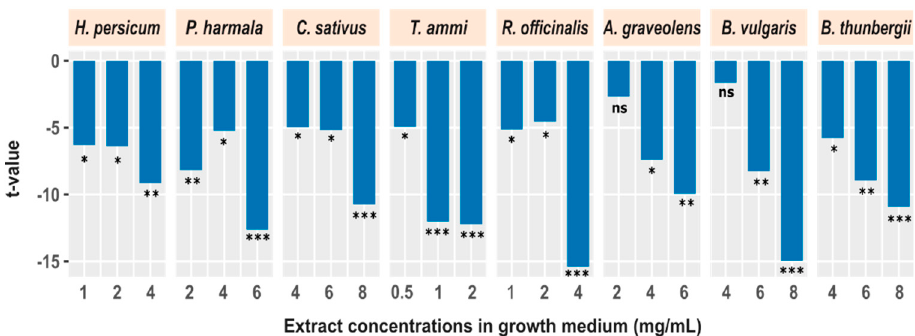
Figure 3. The effect of different concentrations of plant extracts on production of aflatoxin B1 after controlling for the potential impact of fungal growth. Each bar shows the comparison of aflatoxin B1 between all treatment conditions (different extracts and doses) and control, using a GLM to regress out the effect of fungal growth (* p < 0.05; ** p < 0.01; *** p < 0.001; ns: not significant).